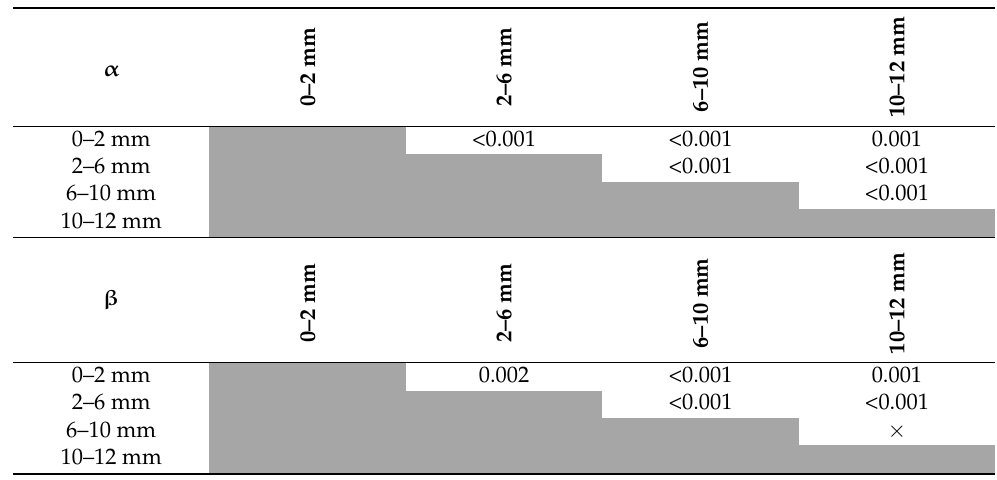
Table 3. p -value for pairwise comparisons from ANOVA post-hoc test (adjustment for multiple comparisons: Bonferroni) for parameters α and β with corneal area considered. The lack of statistical significance is marked with a cross ( × ).